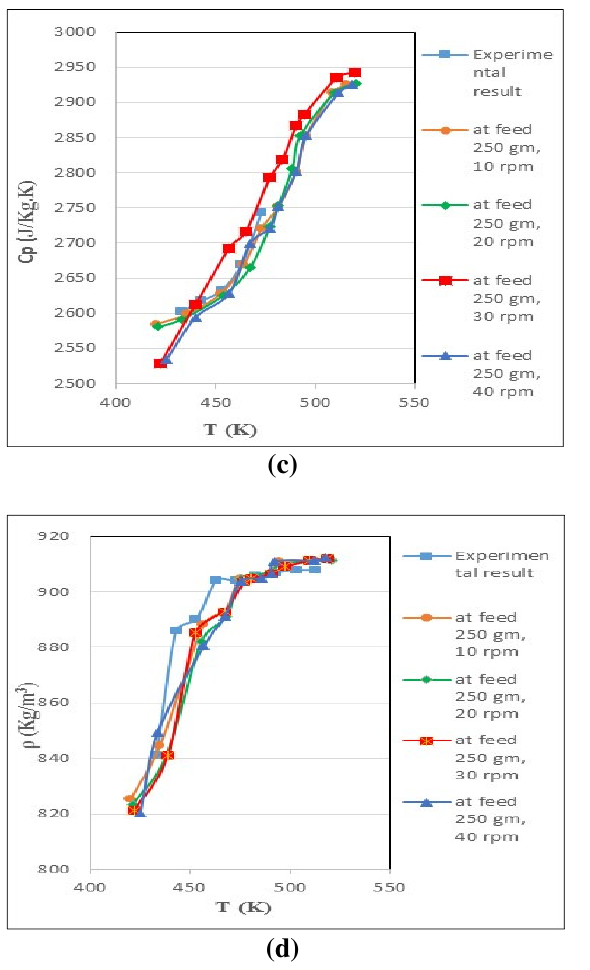
Fig. 14. Thermophysical properties of polypropylene 575 for experimental and simulation results at different temperature (a) Viscosity, (b) thermal conductivity, (c) Specific heat, (d) Density .